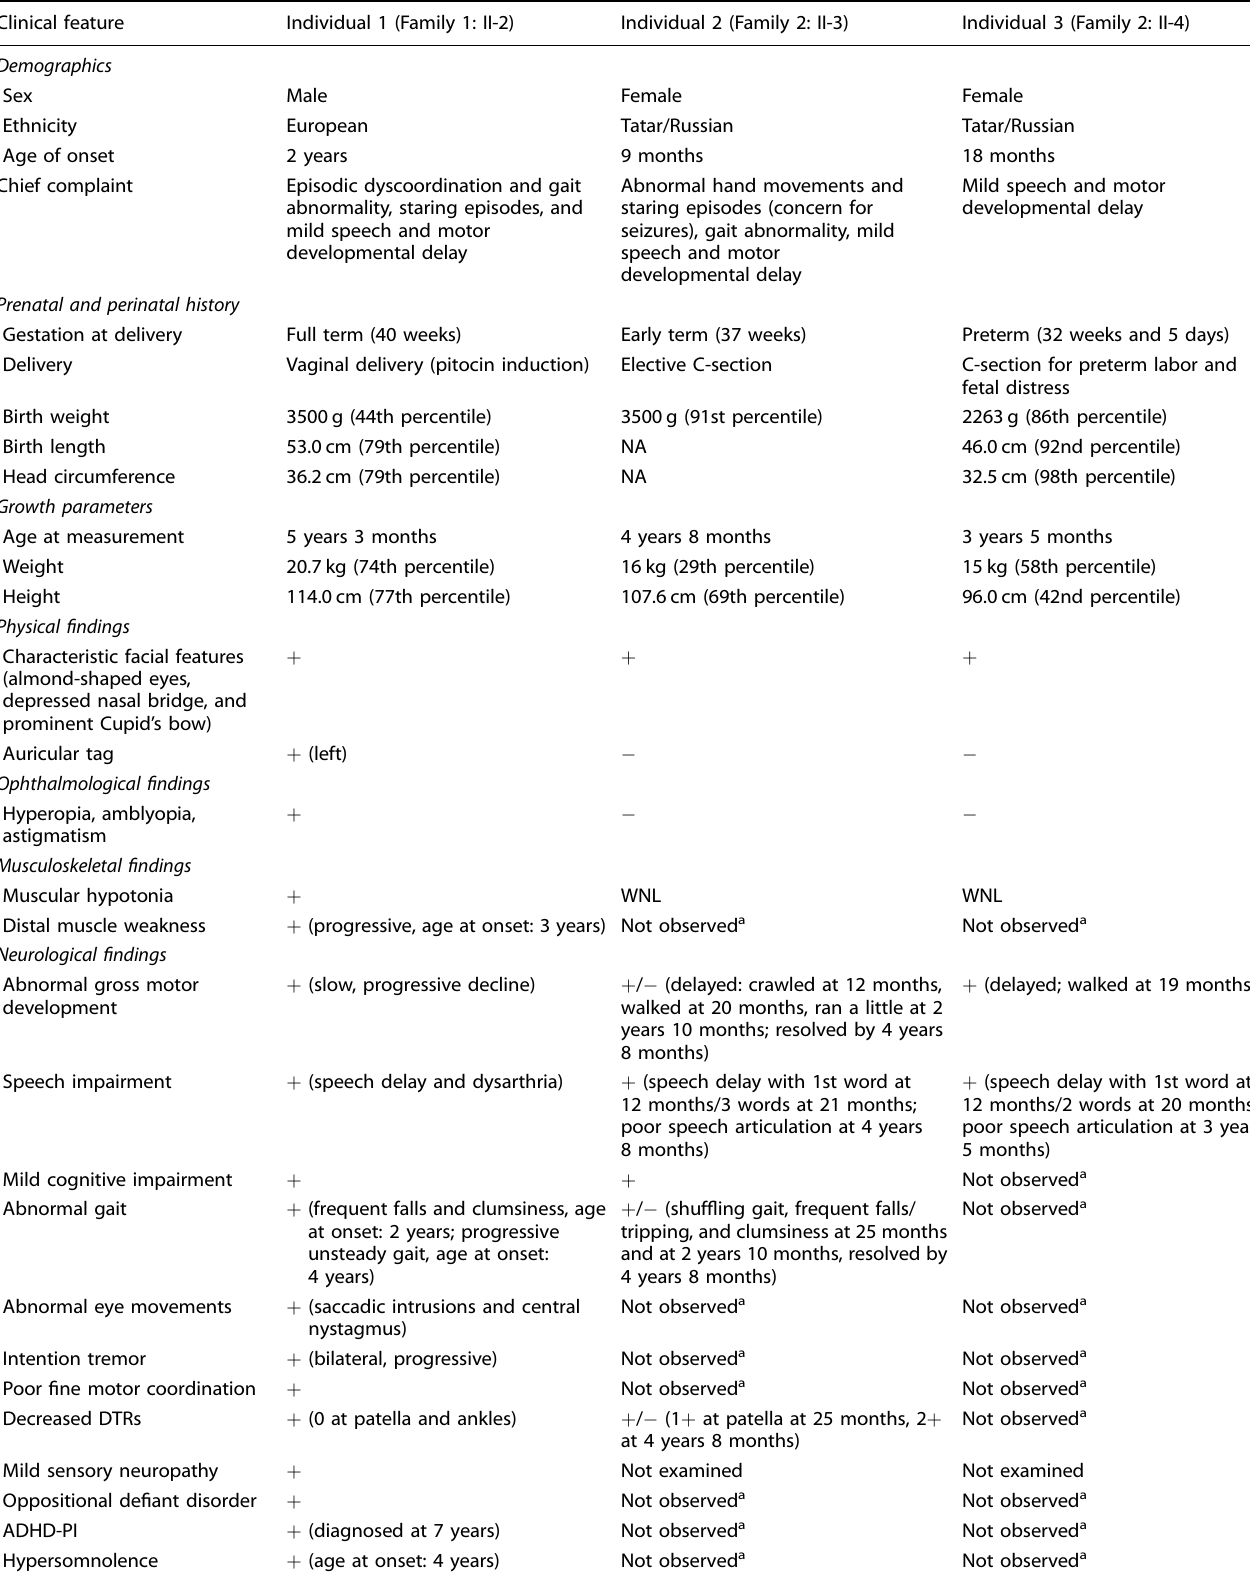
Table 1. Summary of clinical features of individuals with bi-allelic ATG4D variants. Clinical